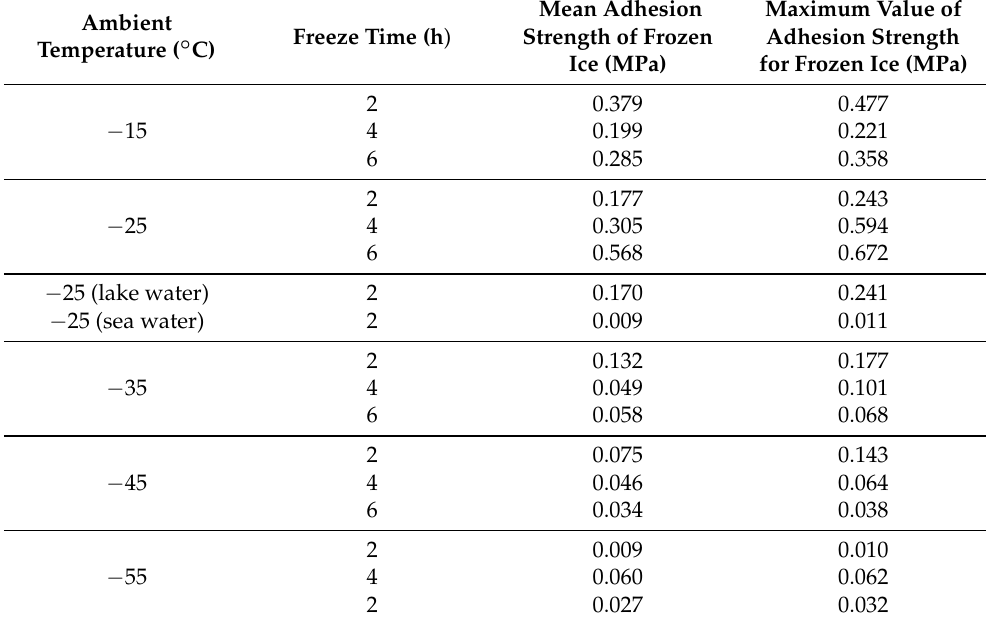
Table 7. Ice-breaking load of AL-Ice-AL specimens in shear tensile